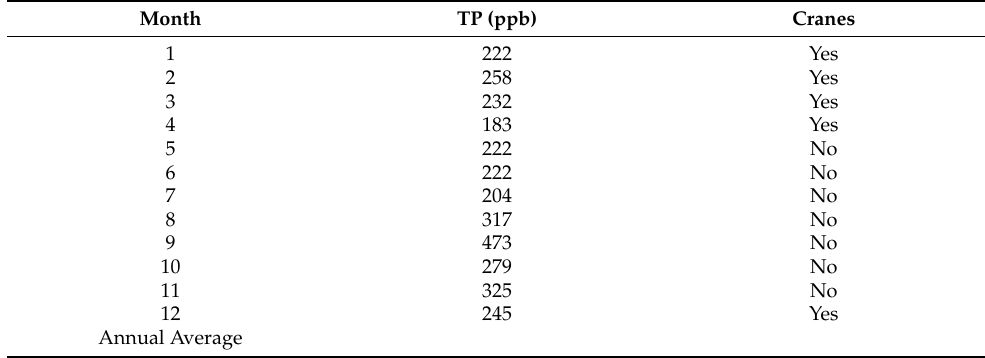
Table 4. Monthly averages (1994–2018) of TPout concentration (ppb) in the outflow from Lake Agmon. Month TP (ppb)